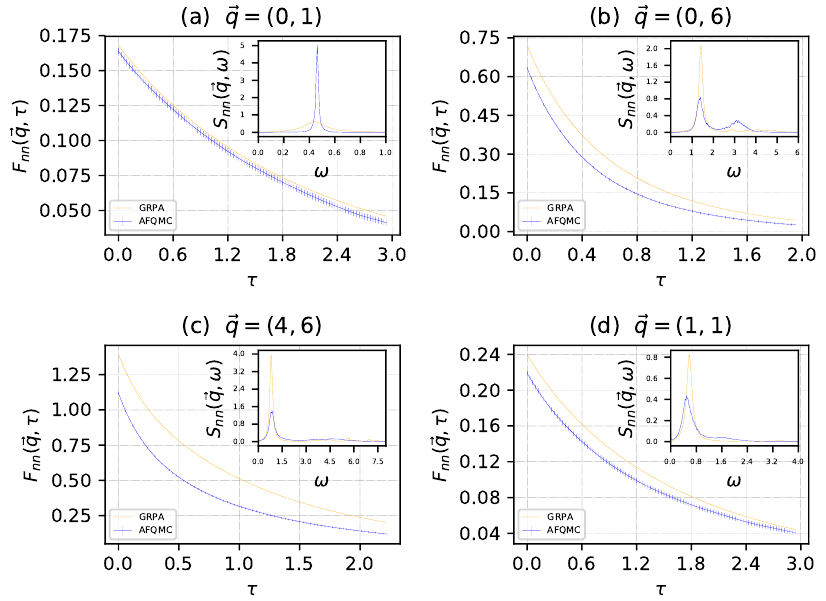
Figure 1. The density–density imaginary time intermediate scattering function F nn ( q , τ ) (main sub-panel), and corresponding density–density dynamical structure factor S nn ( q , ω ) (inset), for the momenta: q = ( 0,1 ) ( a ), q = ( 0,6 ) ( b ), q = ( 4,6 ) ( c ), q = ( 1,1 ) ( d ), in units of 2 π AFQMC data and orange indicates GRPA data.